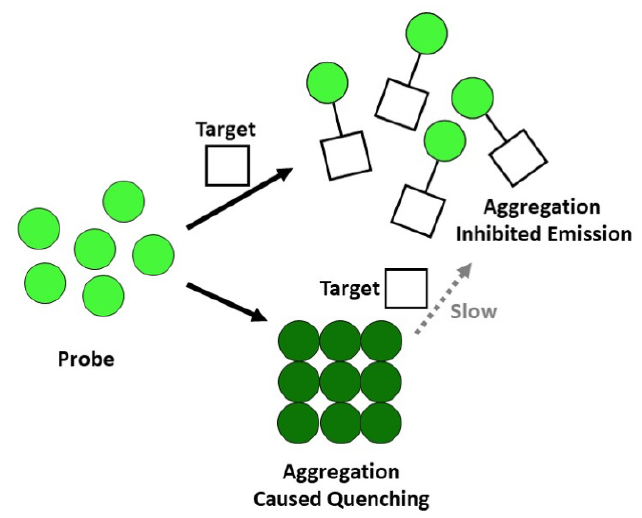
Figure 8. Proposed mechanism for the fluorogenic behavior of p-MB in the presence of charged thiols.